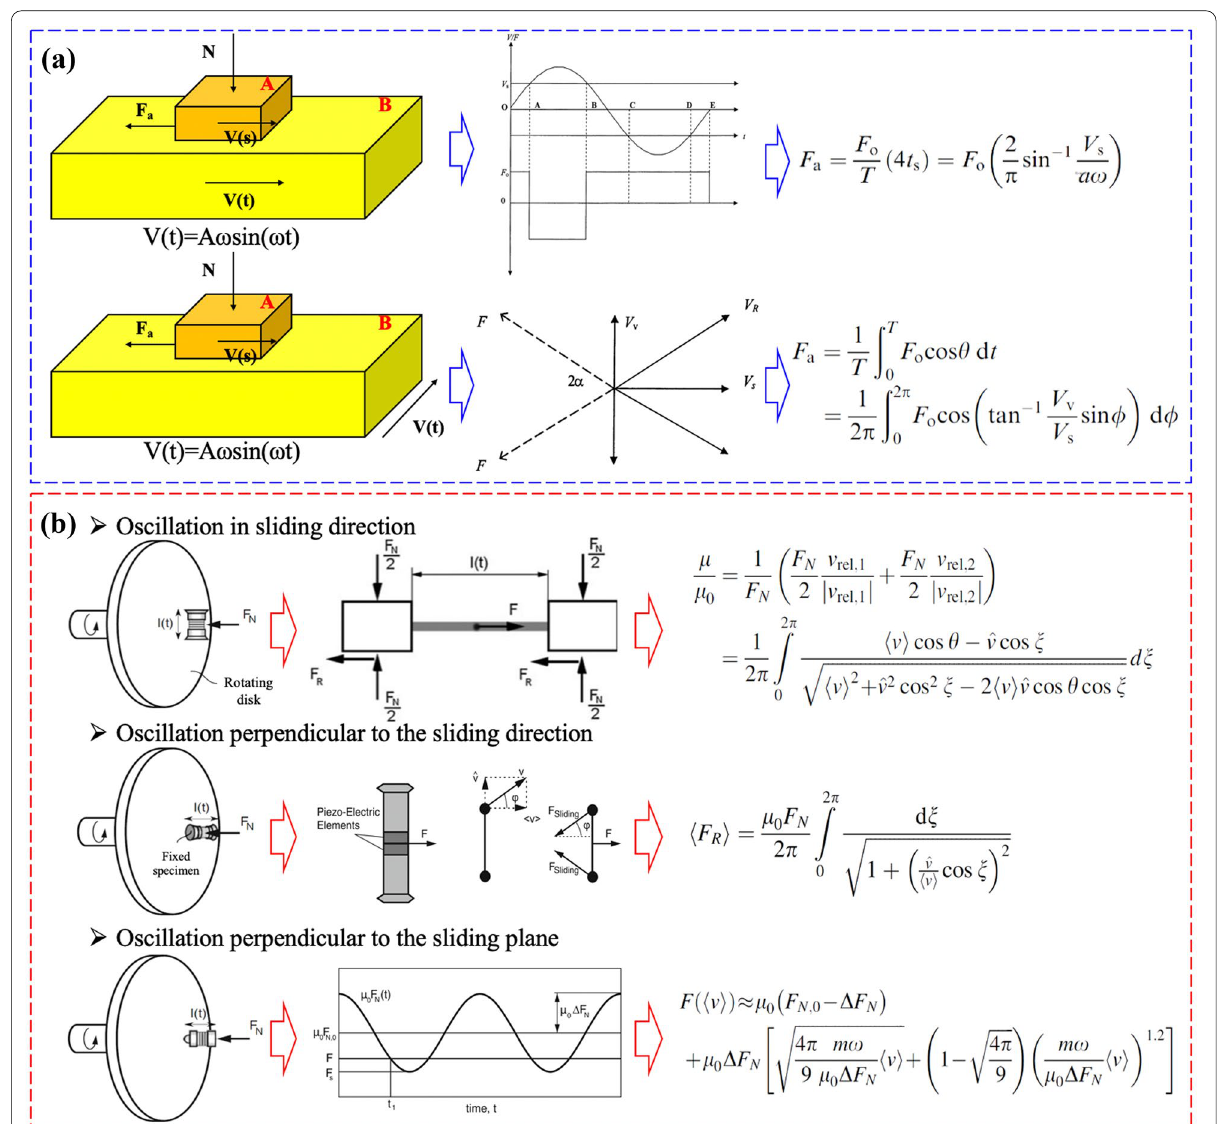
Figure 8 Friction models under different UV directions based on the classic Coulomb friction model: a Kumar models, b Popv models [40, 73,